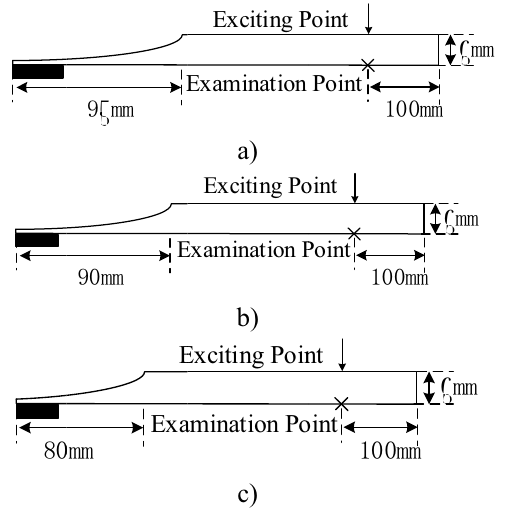
Figure 3: The calculation conditions of acoustic black holes under cut - o ff lengths. ( a ) Condition 1 λ = 5%. ( b ) Condition 2 λ = 10%. ( c ) Condition 3 λ =